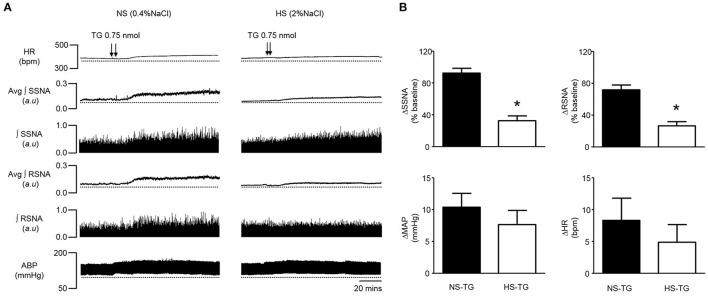
(A) Representative traces showing HR, SSNA, RSNA, and ABP responses to bilateral PVN microinjection of TG (0.75 nmol) in a rat on a 0.4% normal salt (NS) diet (left), and a 2% high salt (HS) (right). Bilateral PVN microinjection (100 nl each) of TG (arrowheads) markedly increased HR, SSNA, RSNA and ABP in a NS diet rat, whereas responses were attenuated in a rat fed a HS diet. (B) Summary data showing peak changes in SSNA, RSNA, MAP, and HR after bilateral PVN microinjection of TG (0.75 nmol) in normal salt (NS, n = 6) and high salt (HS, n = 6) rats. Note that SSNA and RSNA responses to PVN TG were significantly attenuated in HS rats compared to NS. *P < 0.05 HS vs. NS (unpaired student t-test). Avg, average; ∫, integrated.